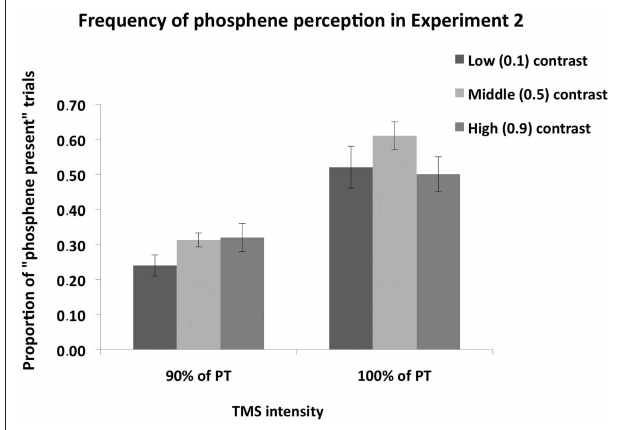
Figure 4 | Mean ( n = 8) proportion of “Phosphene present” judgments in experiment 2. The measure is collapsed over the three response types which indicate that a phosphene was perceived, i.e., “weak,” “almost clear” and “absolutely clear” on the response scale rating. Error bars represent ± 1 SEM. Mental imagery contrast interacted with TMS intensity. When TMS was applied at 90% of PT, significantly more phosphenes were perceived in the high and middle contrast conditions relative to the low contrast condition, indicating that an increase in luminance contrast enhances visual cortical excitability. When TMS was applied at 100% of PT, a significant difference was found between the low and middle contrast conditions, but not between the low and high contrast